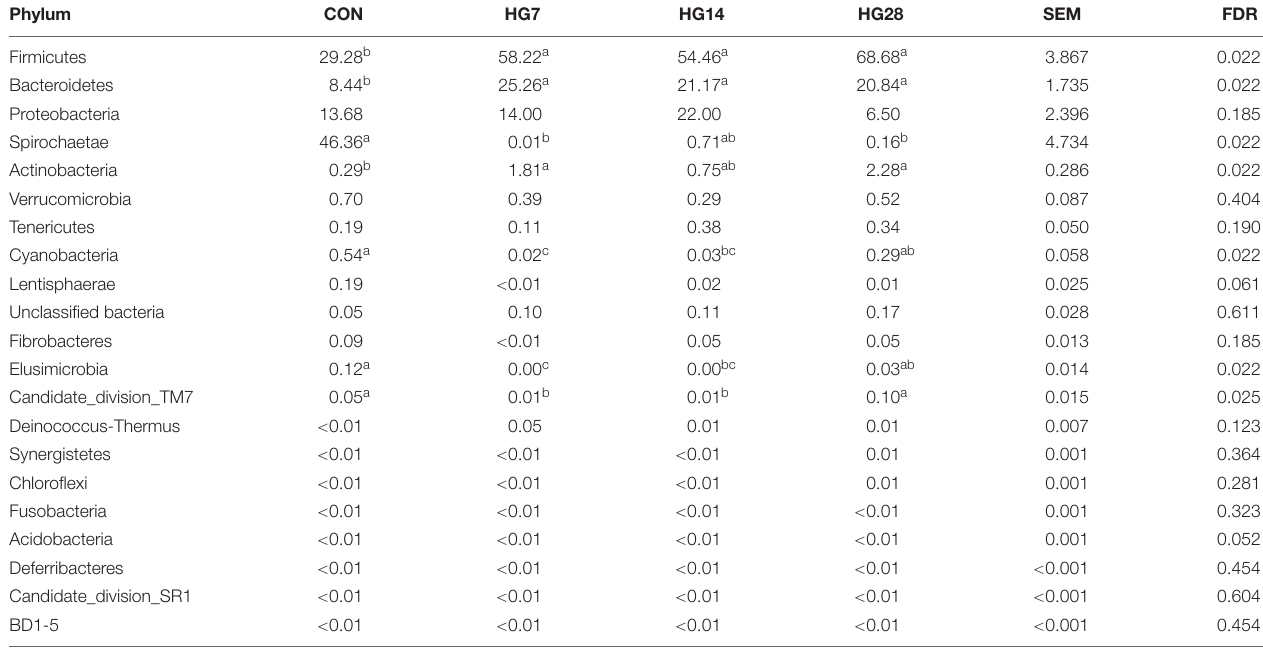
TABLE 3 | Effects of feeding a high-grain (HG) diet on average relative abundance of phylum (% of total sequences) in colonic mucosa. Phylum